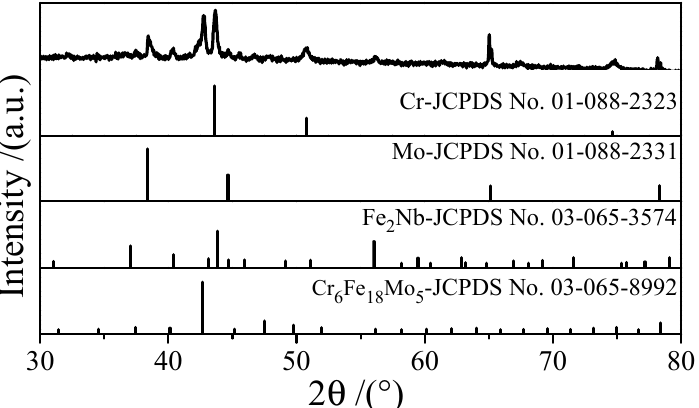
Figure 13. XRD patterns of the alloy residue.